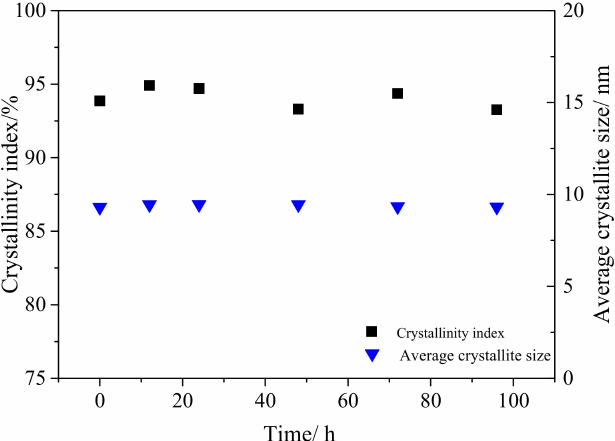
Figure 8. The variations of CrI and average crystallite size ( I hkl ) of tunicate cellulose during the enzymatic hydrolysis.